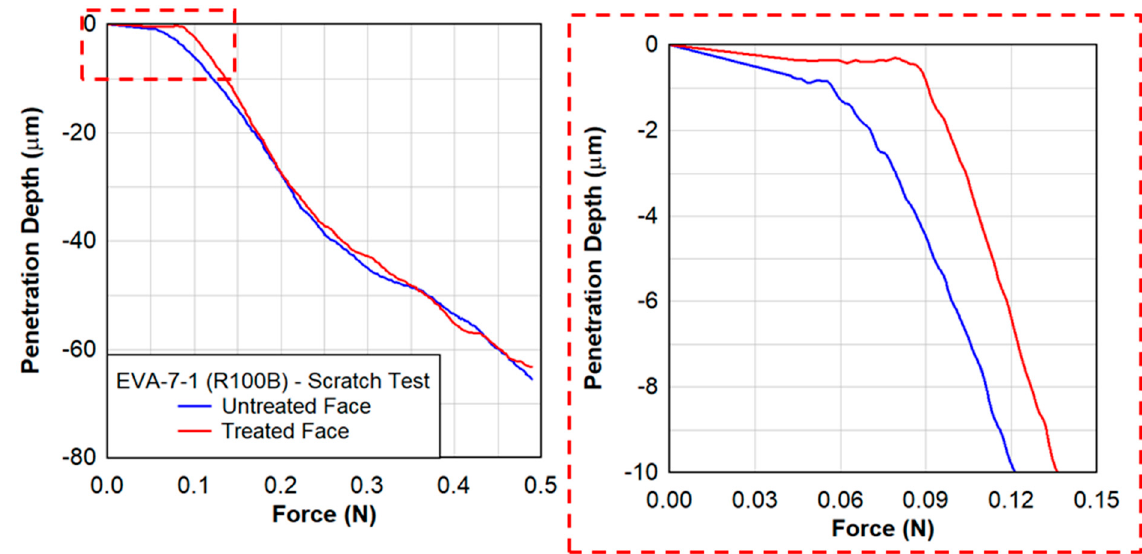
Figure 16. Scratch testing on EVA − 7 − 1 showing the penetration depth as a function of the distance at a scratch rate of 85 mm/min.